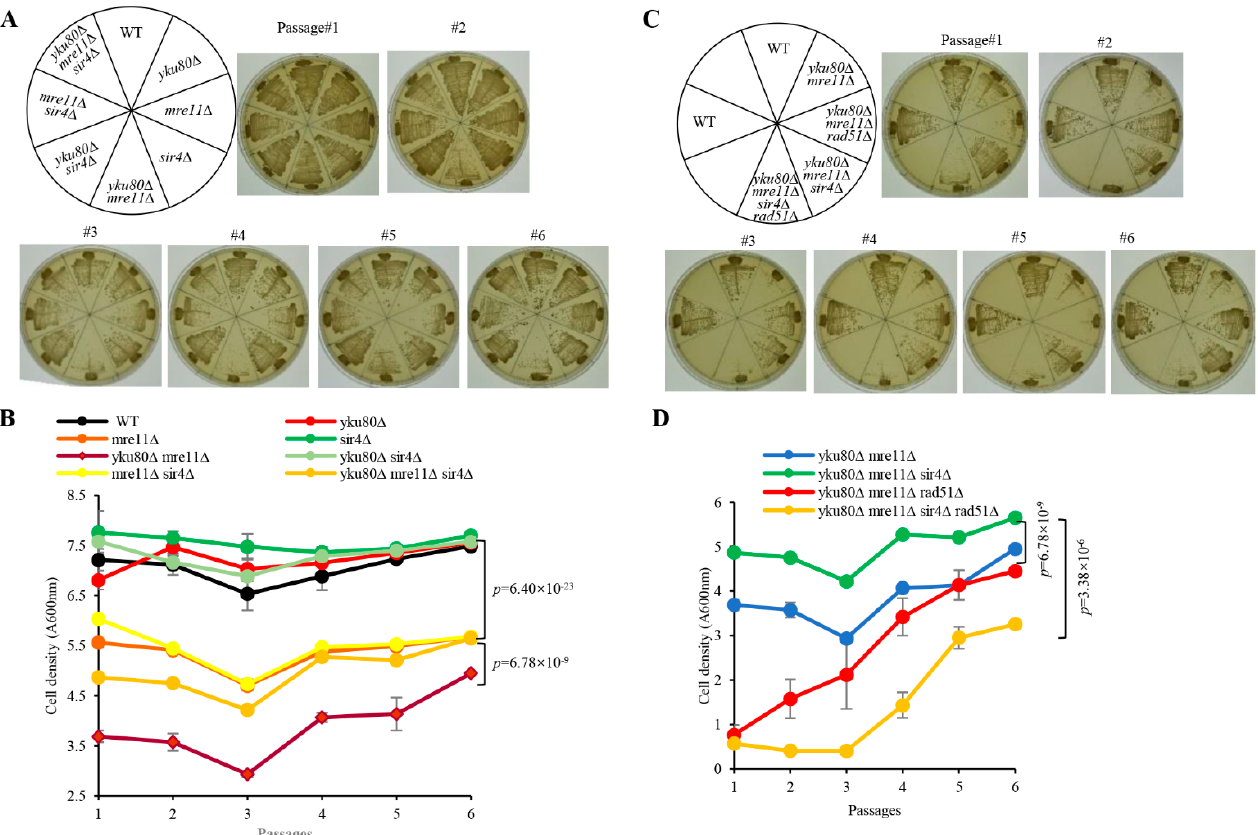
Figure 1. Effects of single and double deletions of SIR4 and RAD51 on senescence. ( A ) Spore WT, yku80 ∆ , sir4 ∆ , mre11 ∆ , yku80 ∆ sir4 ∆ , yku80 ∆ mre11 ∆ , mre11 ∆ sir4 ∆ , and yku80 ∆ mre11 ∆ sir4 ∆ cells were successively streaked on YPD plates every 2 days for six times. Images of photographed colony growth are from one of typical 5 experiments. ( B ) Spore cells indicated in ( A ) were cultured in liquid YPD medium at 30 ◦ C 220 × rpm with initial concentration of A600 nm = 0.01 for around 20 h and followed by A600 nm measurement, and re-dilution was made every 20 h. Results are mean ± SEM ( n = 5). ( C ) Spore WT, yku80 ∆ mre11 ∆ , yku80 ∆ mre11 ∆ sir4 ∆ , yku80 ∆ mre11 ∆ rad51 ∆ , yku80 ∆ mre11 ∆ sir4 ∆ rad51 ∆ cells were successively streaked on YPD plates every 2 days for six times. Images of photographed colony growth are from one of typical 5 experiments. ( D ) Spore cells indicated in ( C ) were cultured in liquid YPD medium at 30 ◦ C 220 × rpm with initial concentration of A600 nm = 0.01 for around 20 h and followed by A600 nm measurement, and re-dilution was made every 20 h. Results are mean ± SEM ( n =